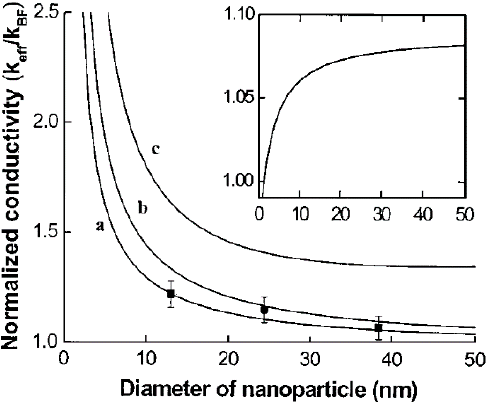
Figure 8. Nanoparticle size ‐ dependent thermal conductivity of nanofluids [85].